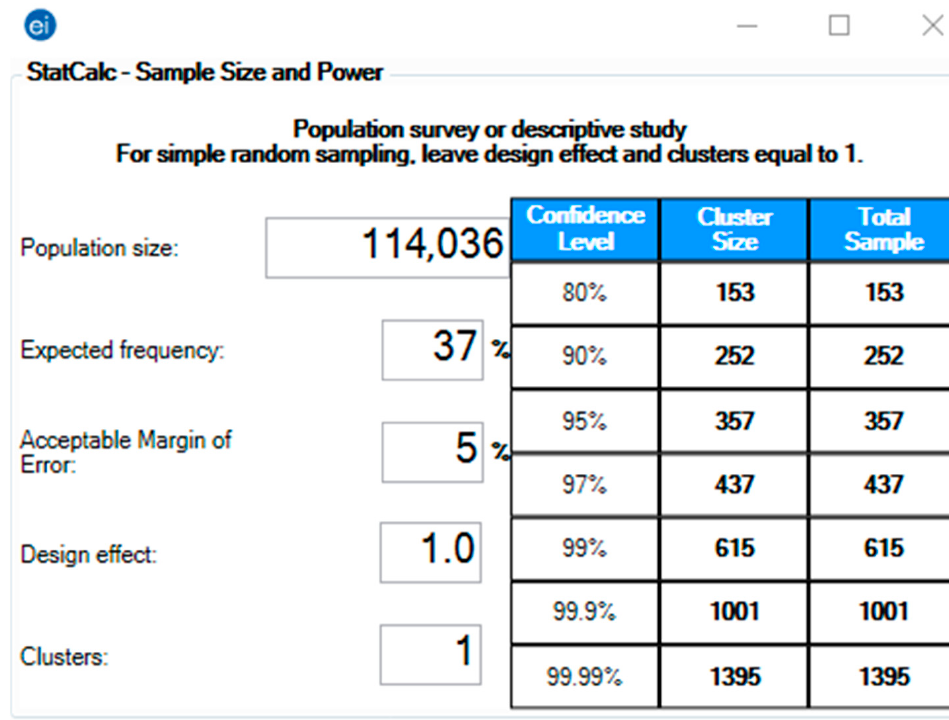
Figure 1. Sample size of Pregnant and Lactating Women (PLW) in the Czech Republic, Epi-Info version 7.2.4 [27–31].